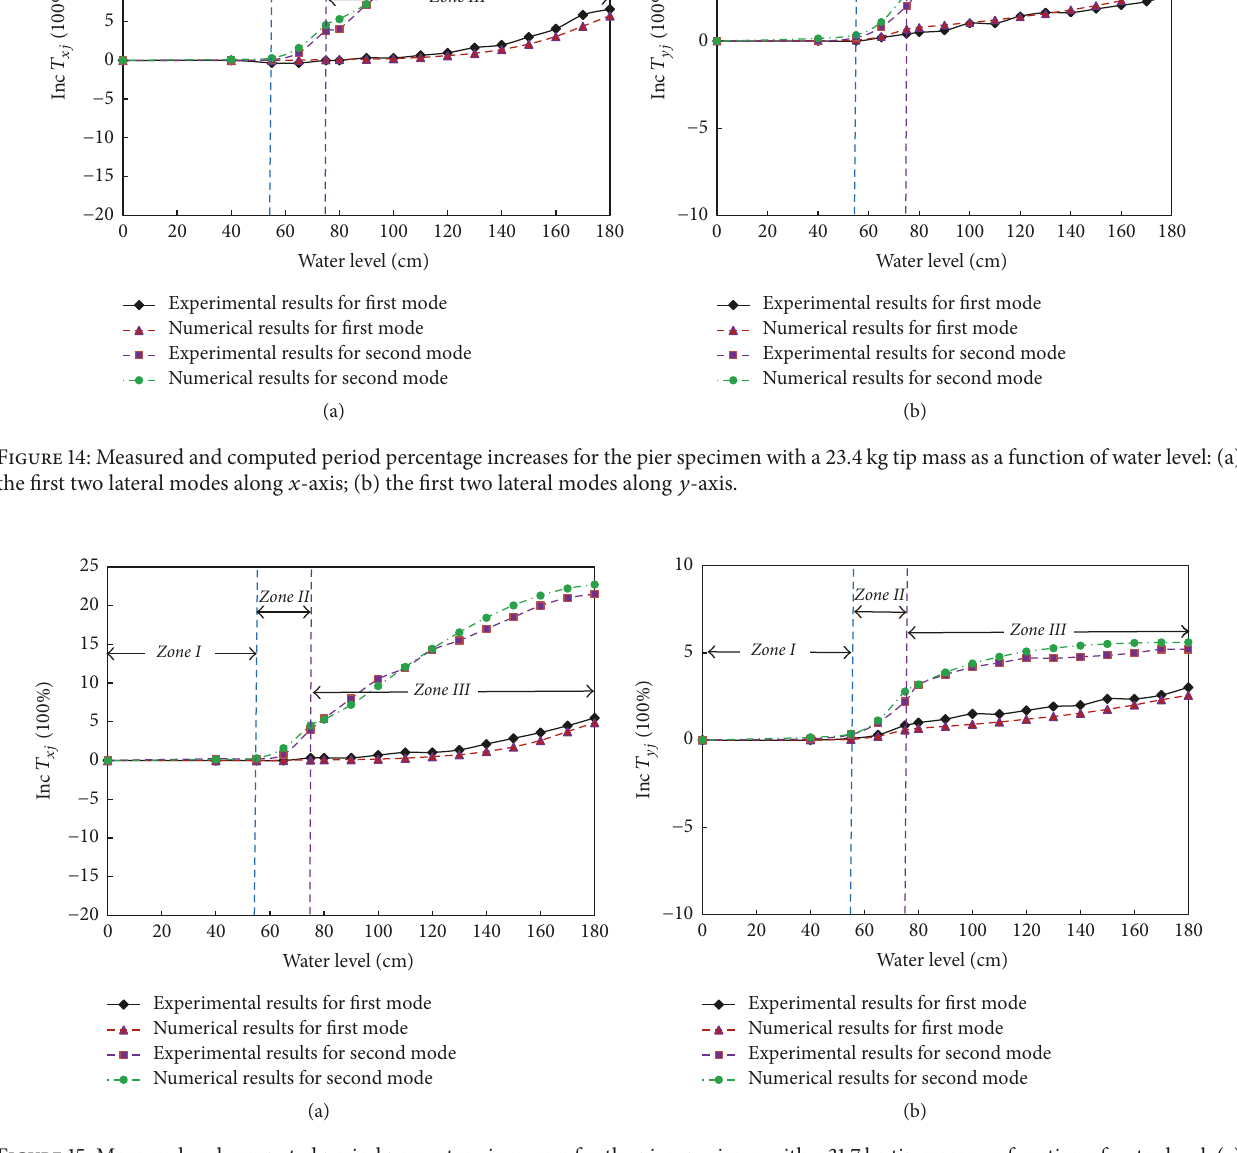
Figure 15: Measured and computed period percentage increases for the pier specimen with a 31.7 kg tip mass as a function of water level: (a) the first two lateral modes along 𝑥 -axis; (b) the first two lateral modes along 𝑦